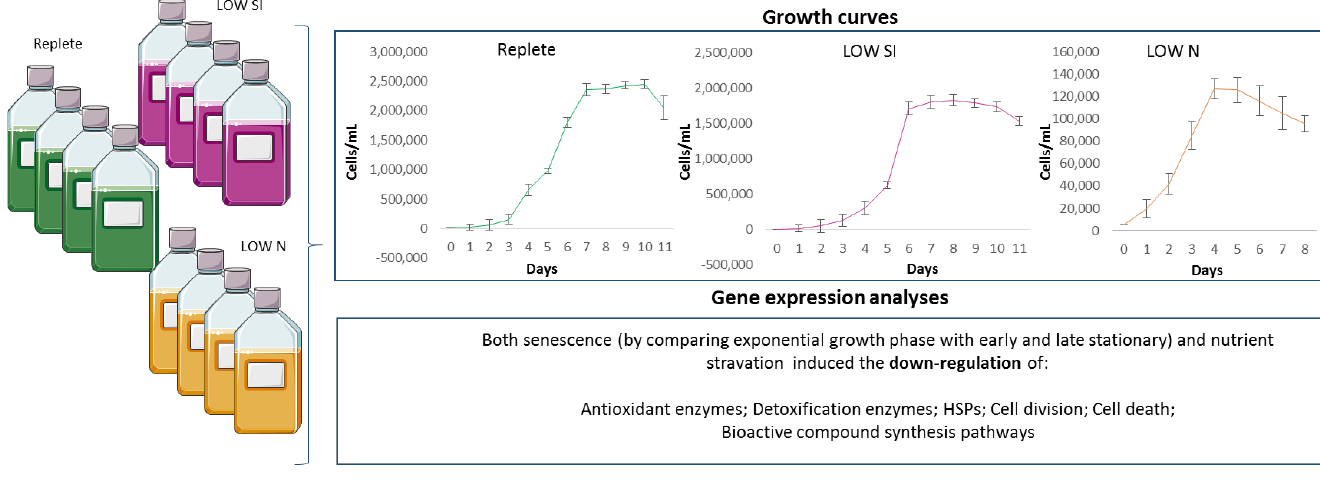
Figure 5. Schematic representation of the main results. In the reported growth curves of the three culturing conditions (replete, LOW SI and LOW N conditions) error bars represent the standard deviation of biological